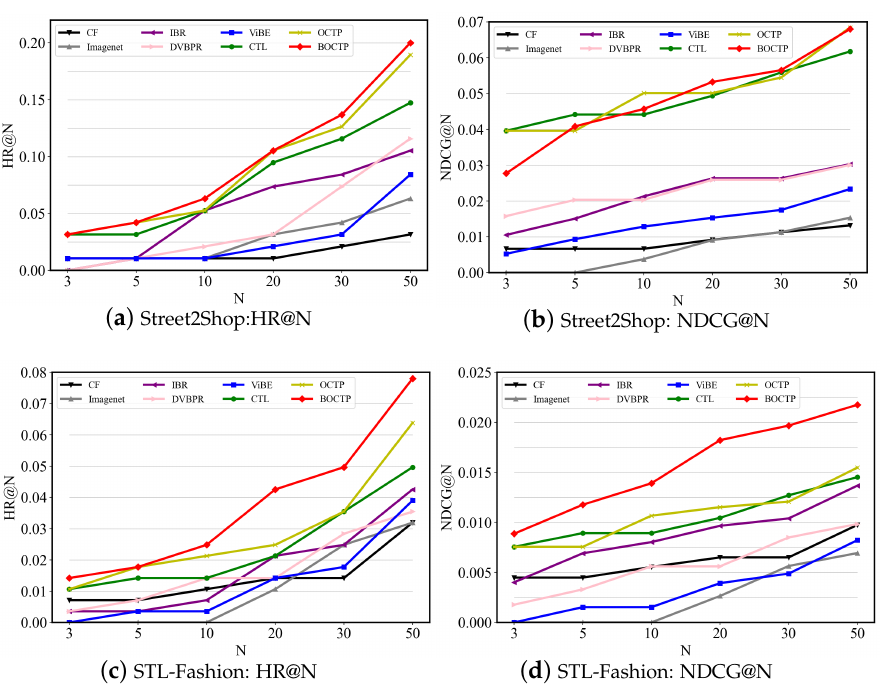
Figure 8. HR@N and NDCG@N on Street2Shop and STL-Fashion ‘clothes’ datasets for non-label- given task, where N ∈ { 3,5,10,20,30,50 } .